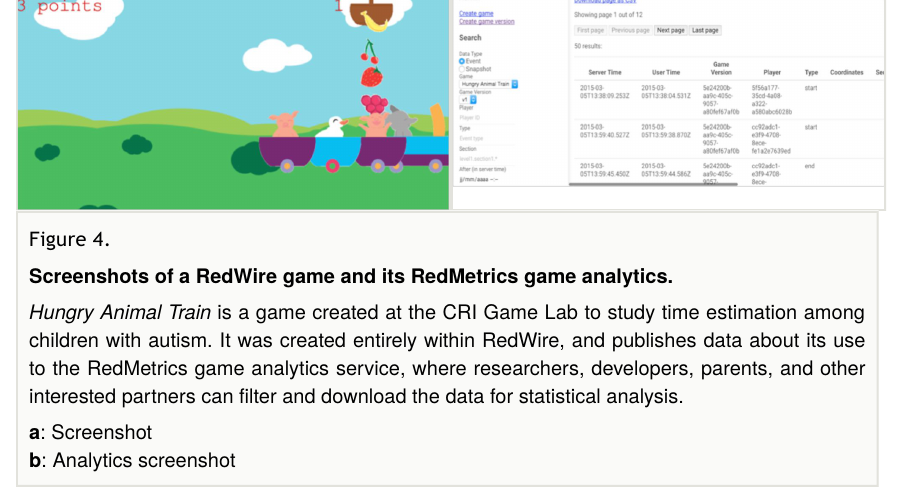
RedMetrics (Fig. 4) is the fi rst open data, open source game analytics service. Once a game is released, its creators want to track how players interact with it. Knowing where players get stuck or give up is invaluable for improving the player experience and encouraging players to continue. For a scienti fi c video game, it is critical that teachers and curve or gather experimental evidence. Since no open source solution currently exists to